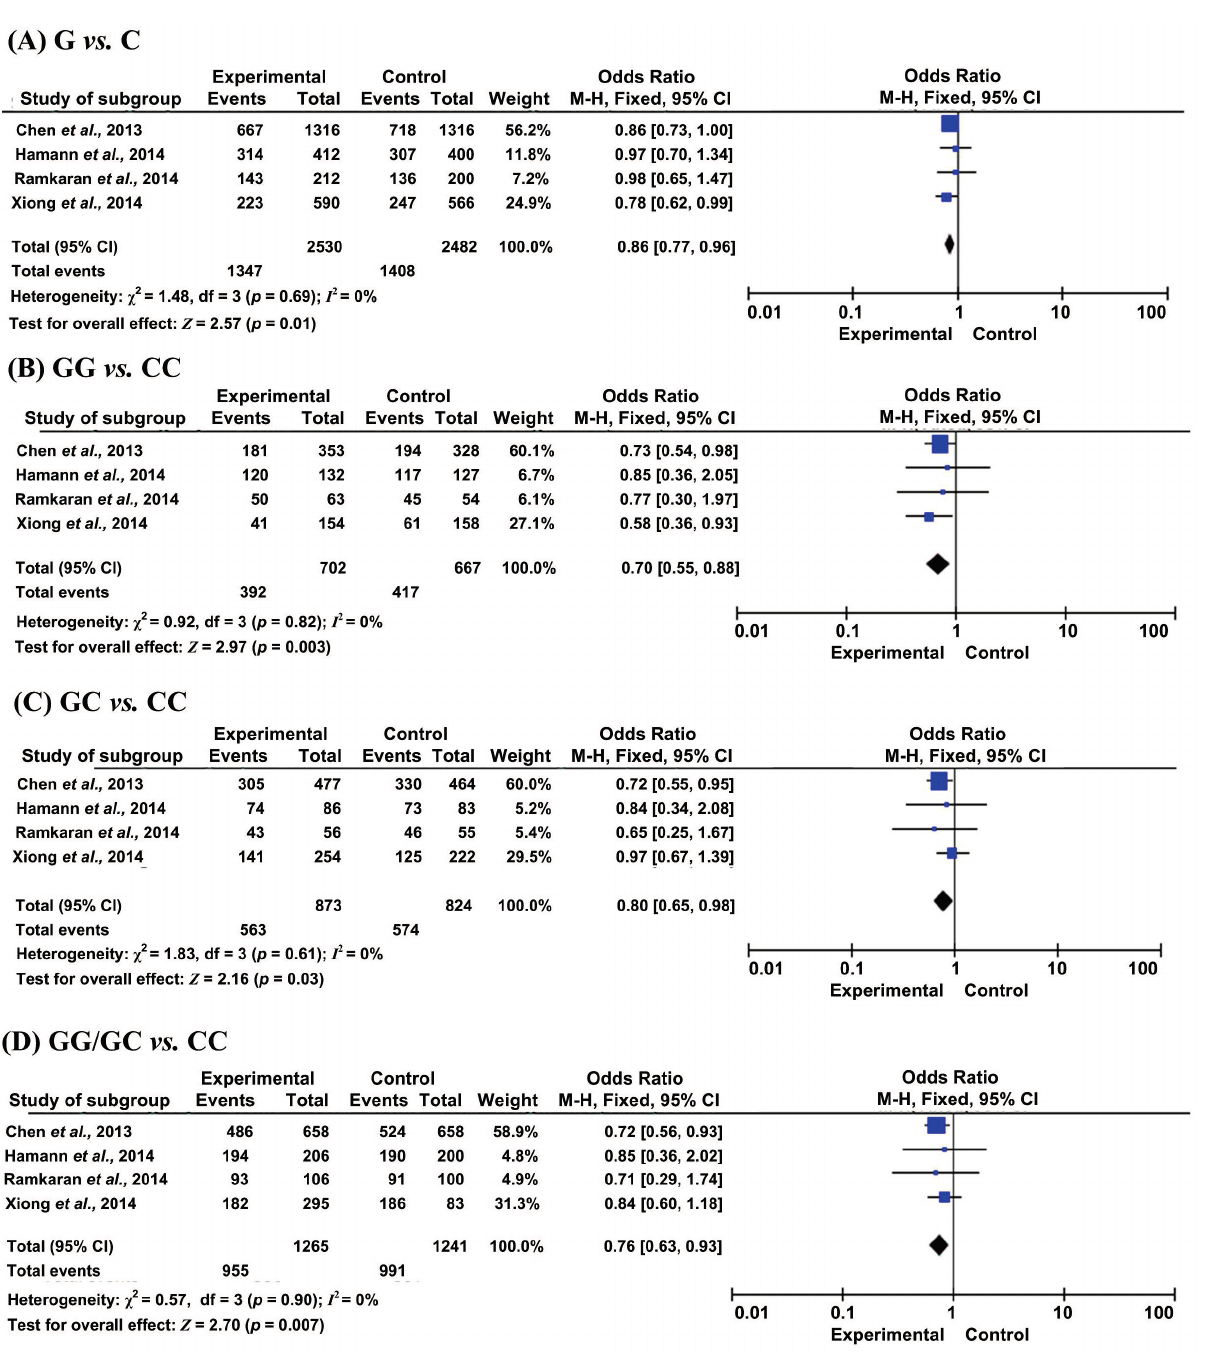
Figure 2. Forest plots of odds ratios for the association between microRNA-146a rs2910164 and the risk of CAD. ( A ) G vs . C; ( B ) GG vs . CC; ( C ) GC vs . CC; ( D ) GG/GC vs .